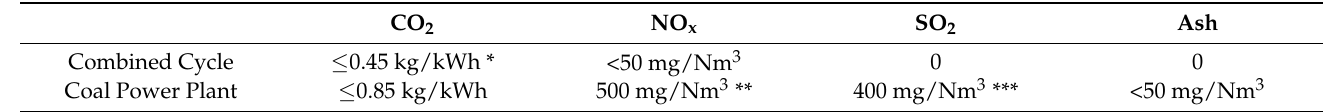
Table 4. Environmental impact of emissions from a combined cycle and a coal-fired power plant (data source: [105].) CO 2 NO x SO 2 Ash Combined Cycle ≤ 0.45 kg/kWh * <50 mg/Nm 3 0 0 Coal Power Plant